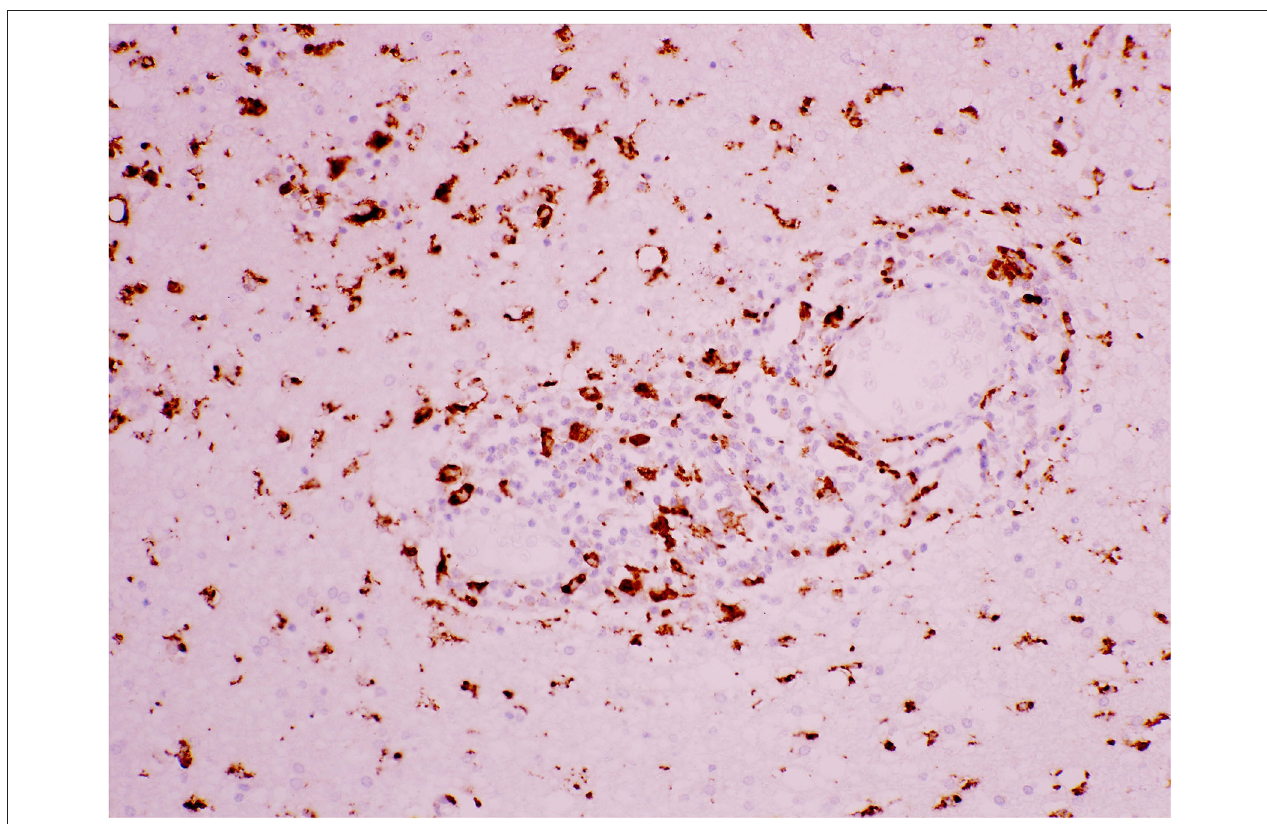
FIGURE 8 | Cerebral white matter: activated CD68 + microglial cells around a vessel and through the neuropil, demonstrated with immunohistochemistry (antibody against CD68). Original magnification ×